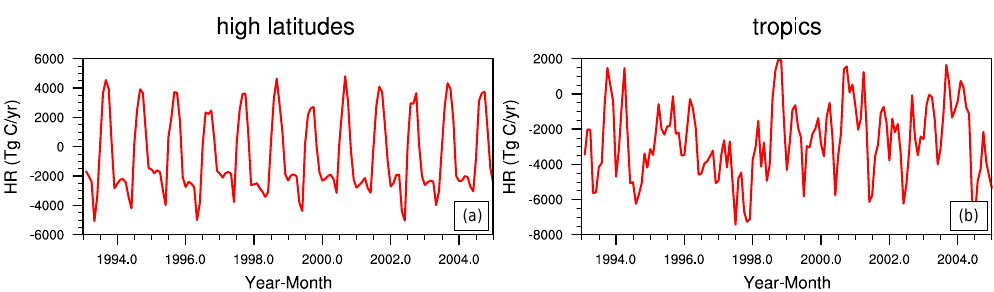
Figure A1. Temporal variation of the difference in HR between CLM4.5 (BGC) and CLM4.0 (CN_a) simulations (CLM4.5 minus CLM4.0) at high latitudes (a) and in tropical regions (b) . We use TgCyr − 1 so that it can be easily compared with Fig. 5.